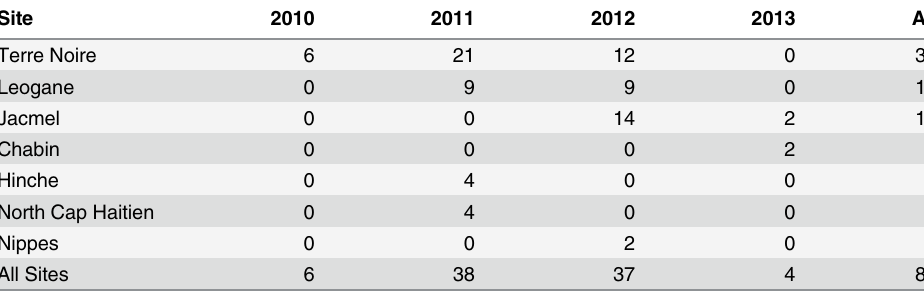
Table 1. Sample size across study sites and collection